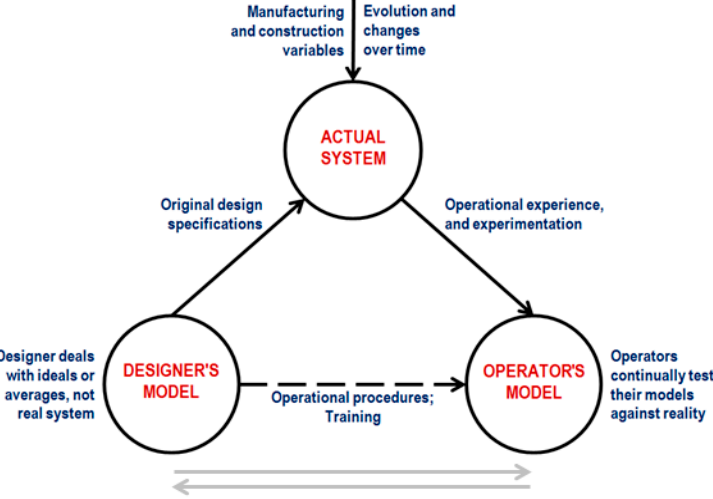
Figure 5. The Role of Mental Models in Systems-theoretic Framework (Adapted from [19]).